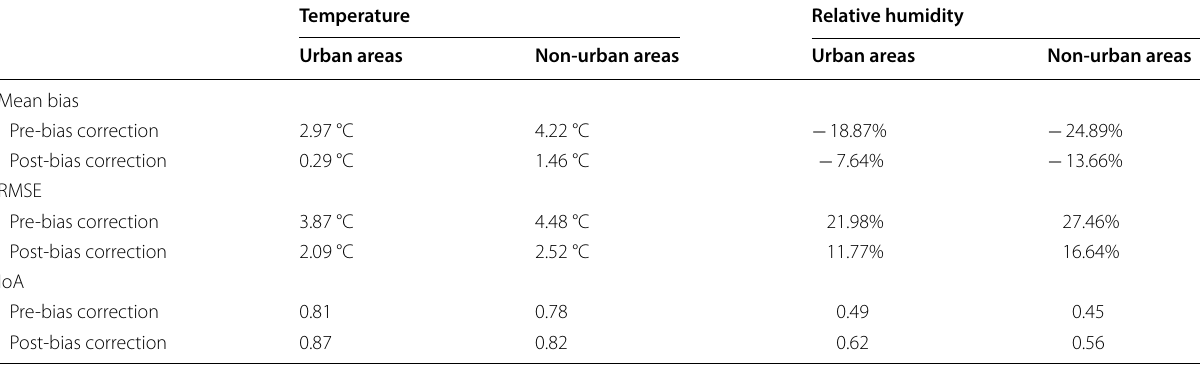
Table 3 Statistical evaluation of UCM simulations after bias